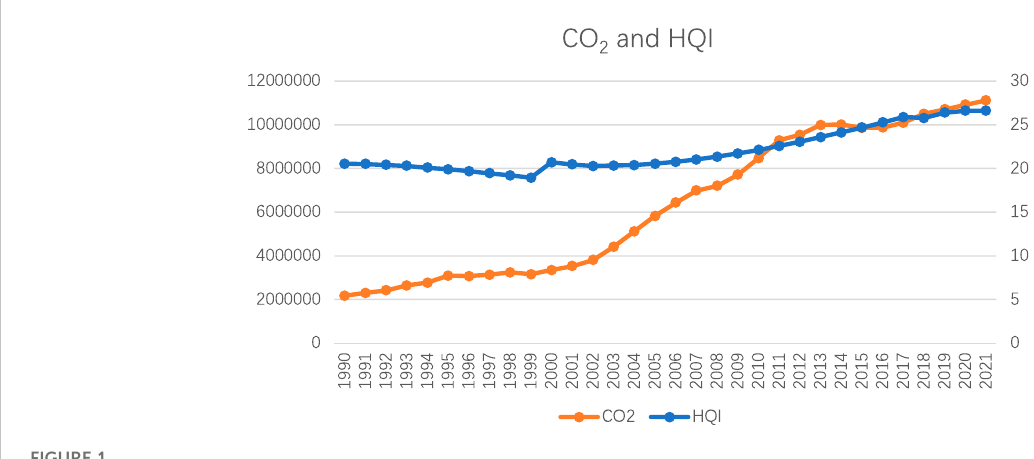
FIGURE 1 CO 2 Emissions and HQI in China. Source: WDI indicators.